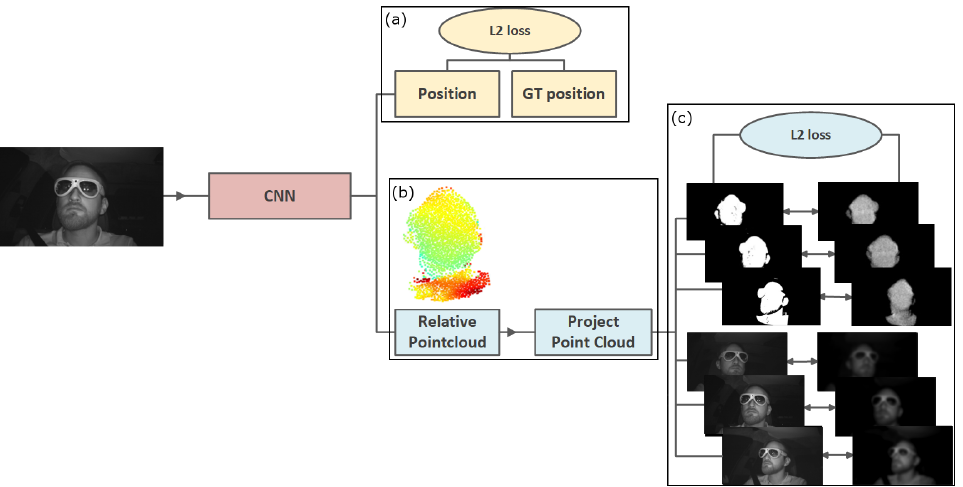
Figure 2. An overview of our overall architecture. ( a ) We estimate the translation based on the ground truth. ( b ) The point cloud estimation is performed with self-supervision based on ( c ) pre-generated masks of the target objects and the intensities of the original images.